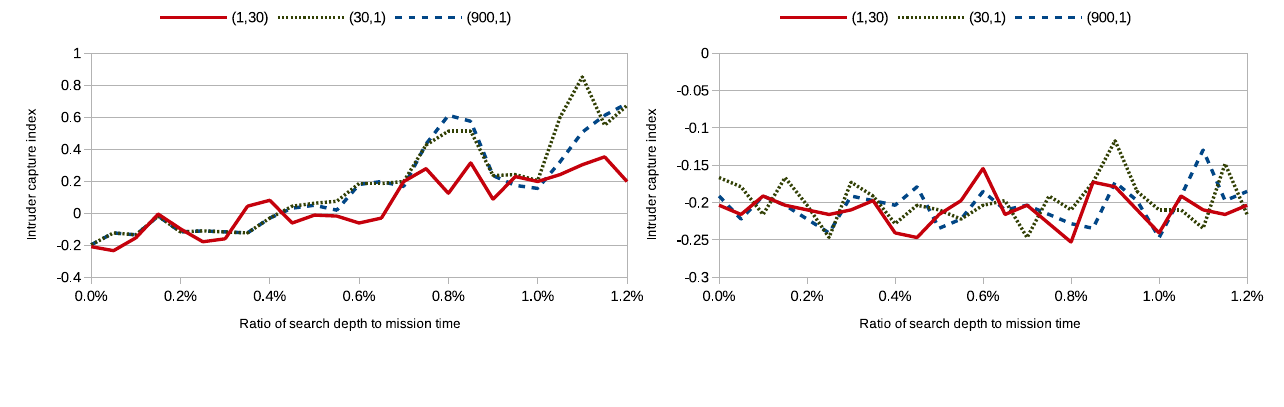
Figure 6. Intruder capture index for Scenario B2 using uavsAction () ( left ) and localSearch () ( right